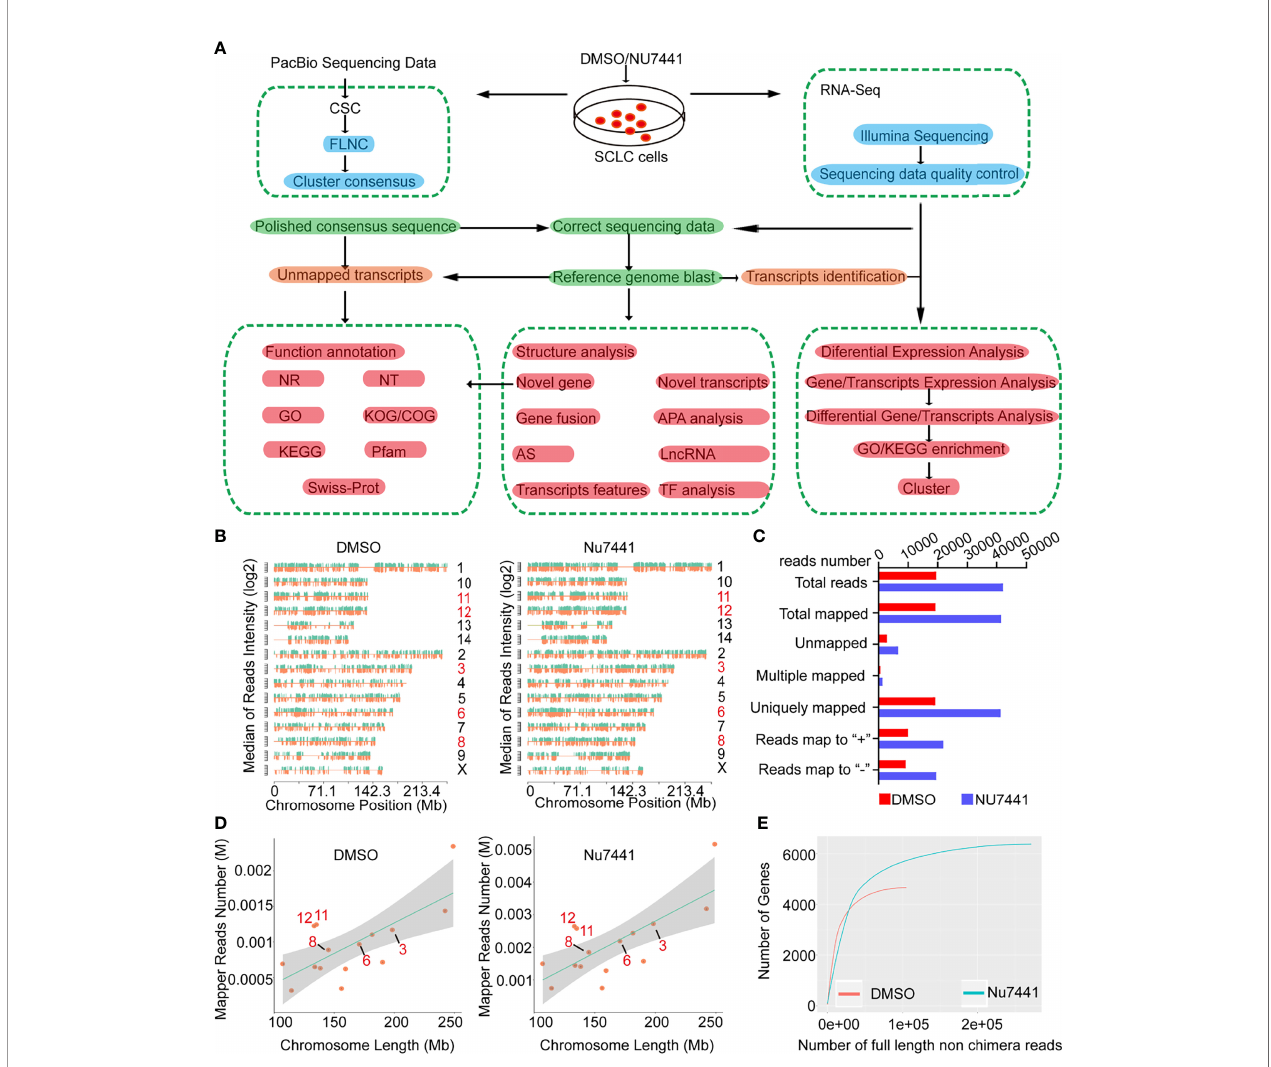
FIGURE 1 | The long-read sequencing fl ow chart and long-read data characteristics. (A) The experimental design and the data processing pipeline of the long-read sequencing. (B, D) The chromosomal distribution of sequencing reads between control cells and NU7441 treated cells. (C) Summary of the reads mapped to the reference genome. (E) The number of genes covered by the long-read sequencing data between control cells and NU7441-treated